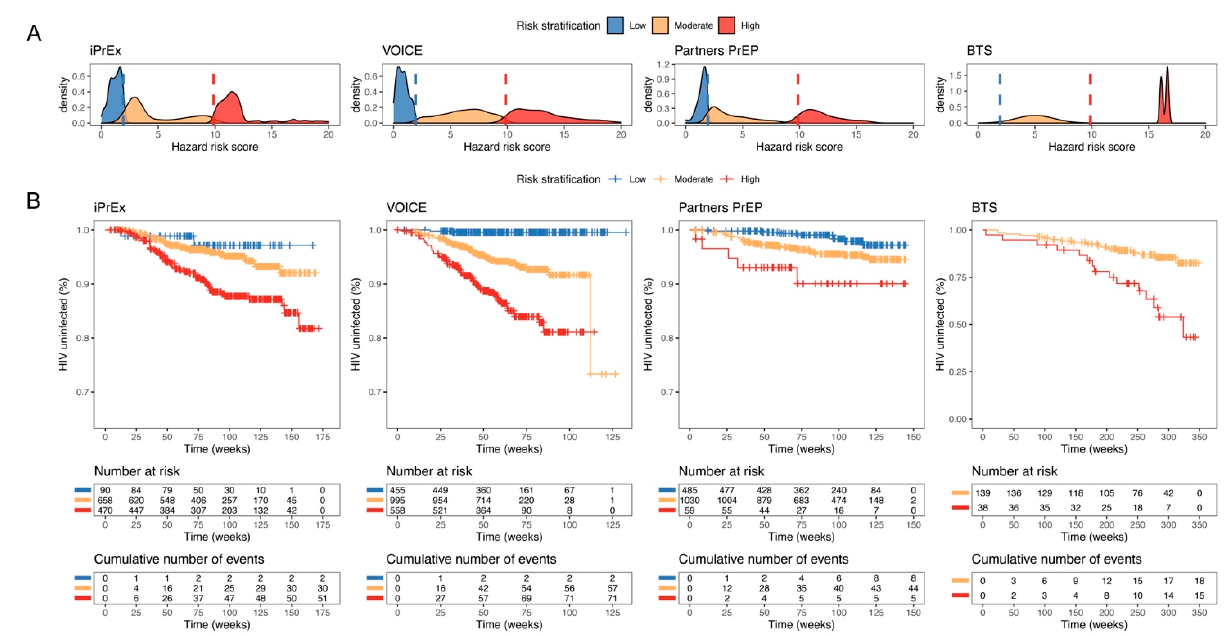
Figure 2. Risk stratification representation. ( A ) Distribution of individual risk scores and ( B ) Observed Kaplan–Meier rates stratified by low, medium, and high-risk group for each study population. Low, medium, and high-risk groups were defined as individuals with a probability of infection over 1 year of < 1%, between 1 and 5%, and >5%. No risk stratification is shown for TDF2 study as no available predictor was included in the model.